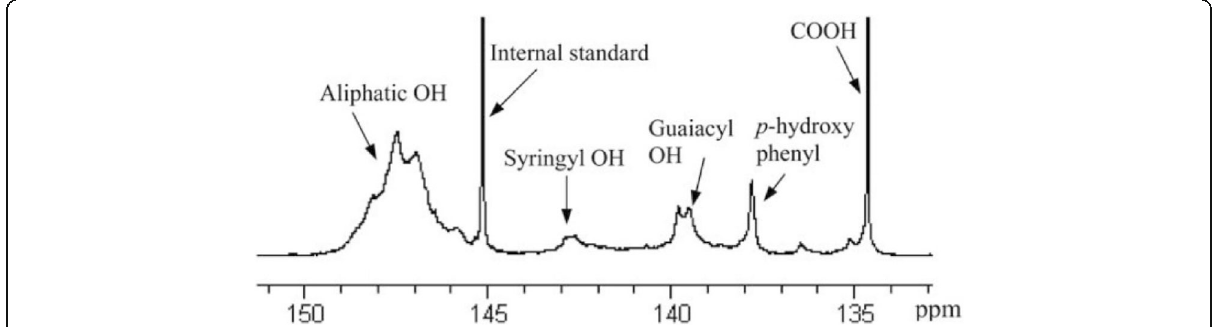
Fig. 4 A typical 31 P NMR spectrum of a switchgrass ball-milled lignin derivatized with TMDP using cyclohexanol as internal standard. Reprinted with permission from ref.